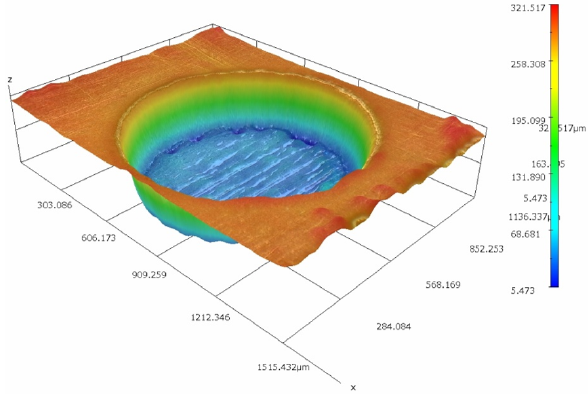
Figure 6: 3D profile of the third sample for trajectory No. 1.